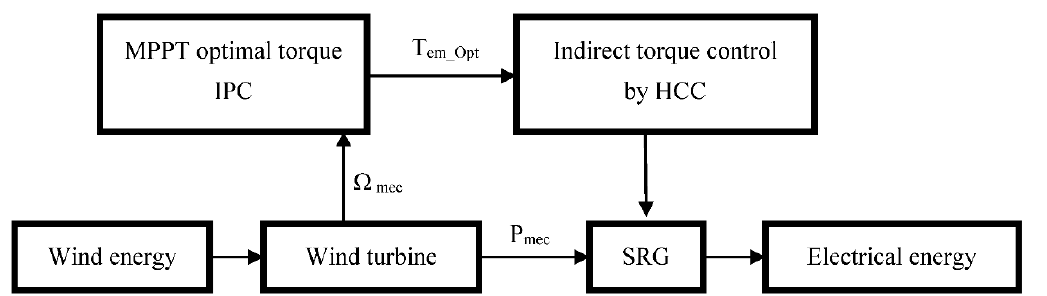
Figure 12. Global flowchart of the proposed association technique.